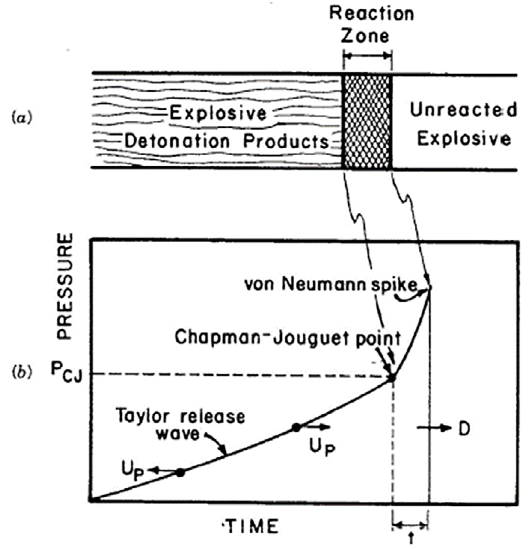
Figure 1. (a) The structure of a detonation shock wave, and (b) the pressure as a function of time (adapted from Meyers 28 ).